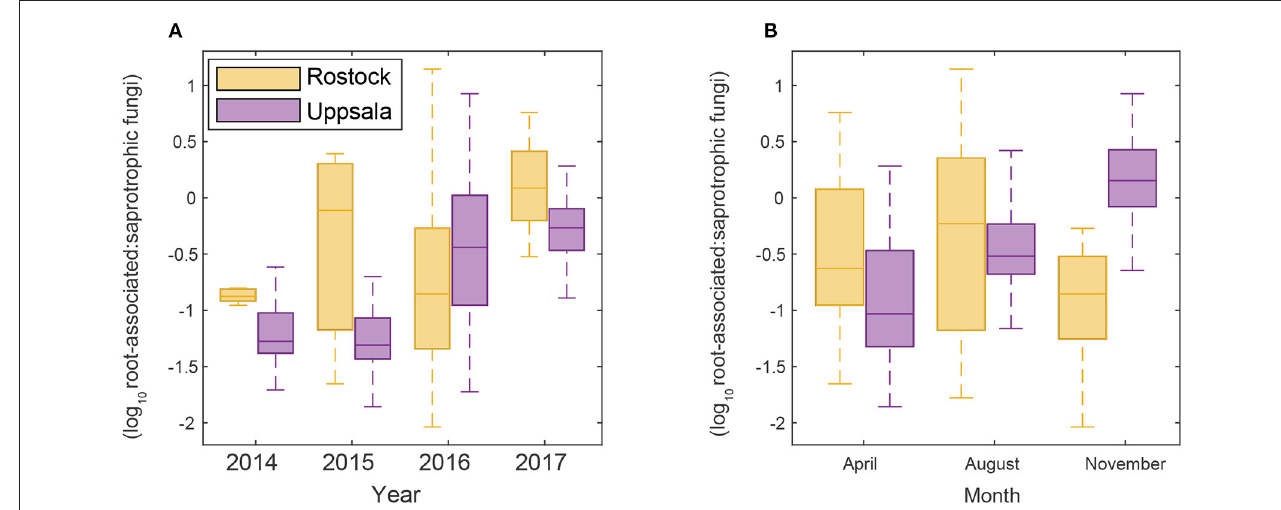
FIGURE 2 | Changes in the proportion of a root-associated over saprotrophic sequence counts (A) throughout time over the study period and (B) seasonally in Rostock and Uppsala.